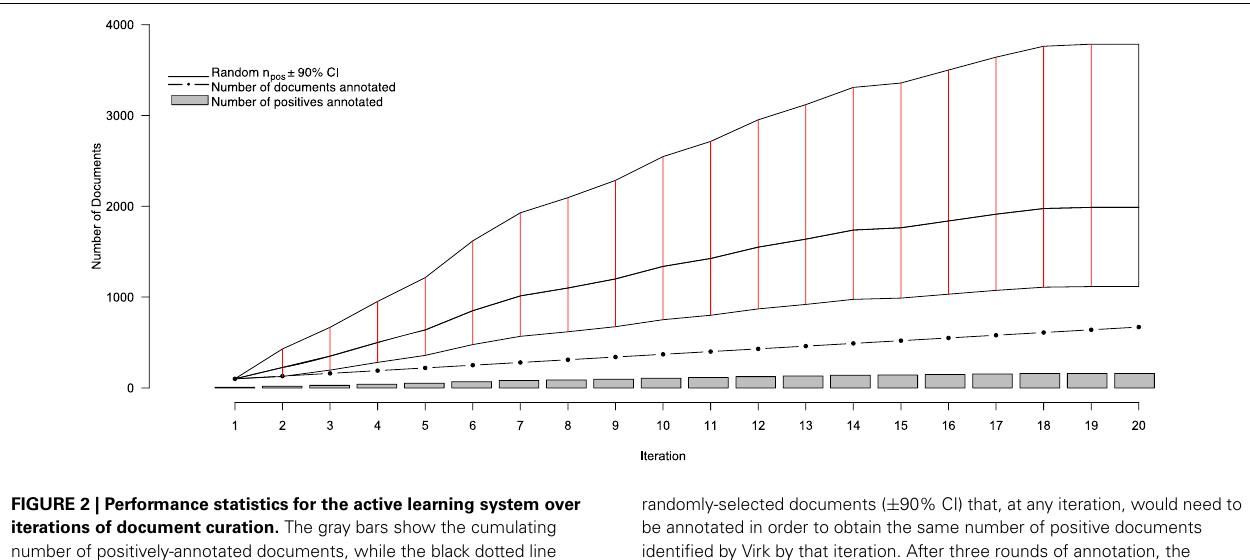
randomly-selected documents ( ± 90% CI) that, at any iteration, would need to be annotated in order to obtain the same number of positive documents identified by Virk by that iteration. After three rounds of annotation, the average number of documents that would have to be read for a given number of positives is statistically significantly greater than that needing to be annotated with the Virk